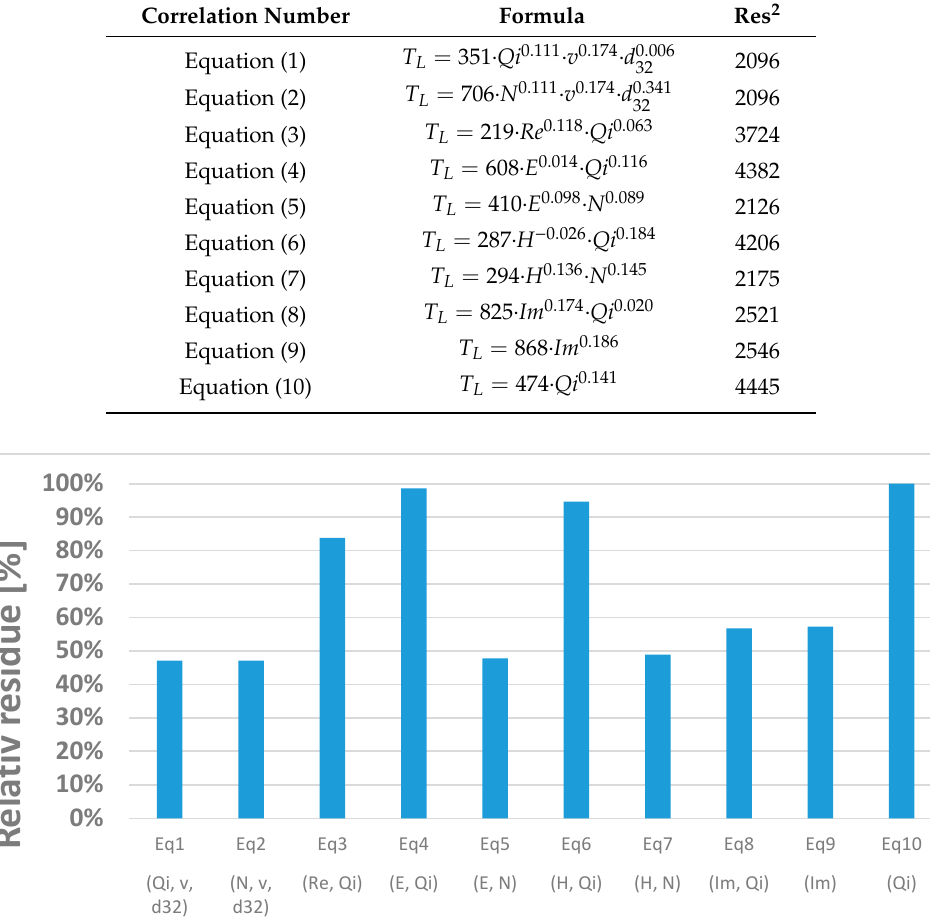
Table 2. The last column “Res2” gives the average square difference between the measured HTC and (cid:2870) (cid:2869) ∑(cid:3435)𝑇 − 𝑇 (cid:3439) the correlated HTC. 𝑅𝑒𝑠 (cid:2870) = , where N is the number of HTC values (cid:3013),(cid:3040)(cid:3032)(cid:3028)(cid:3046)(cid:3048)(cid:3045)(cid:3032)(cid:3031) (cid:3013),(cid:3030)(cid:3042)(cid:3045)(cid:3032)(cid:3039)(cid:3028)(cid:3047)(cid:3032)(cid:3031) (cid:3015) used. 𝑅𝑒𝑠 (cid:2870) for each tested equation is also shown in Figure 9. Not all used parameters are independent. For example, Equations (1) and (2) are equivalent to each other because the number of droplets N (used in Equation (2)) can be expressed by Q i and d 32 (used in Equation (1)). Both are mentioned due to the different difficulty of obtaining the required parameters. Table 2. List of correlations. Table 2. List of correlations.